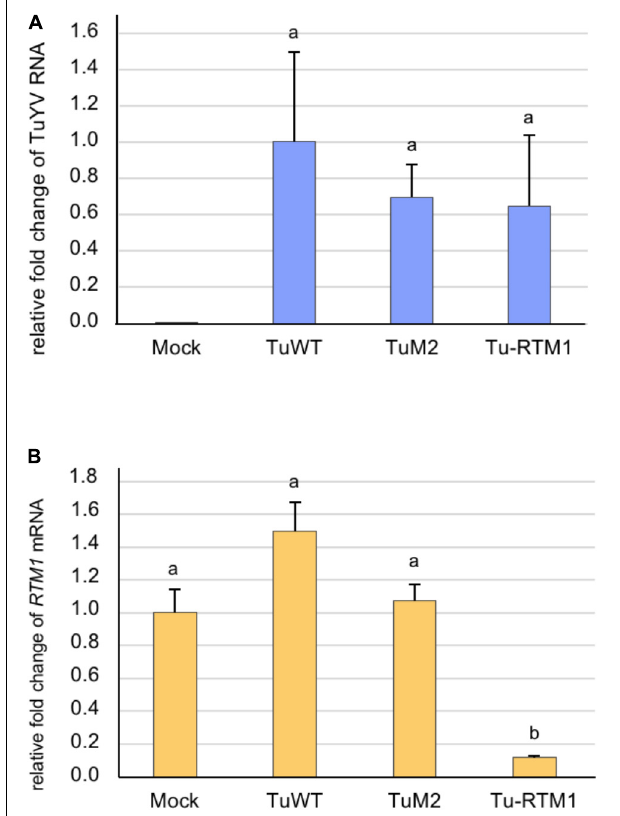
FIGURE 6 | Analysis by real-time RT-PCR of the accumulation of TuYV RNA (A) and RTM1 transcripts (B) in infected A. thaliana Col-0 plants. Plants were either mock-inoculated (mock) or agroinoculated with TuWT, TuM2, or Tu- RTM1 and collected 36 dpi. TuM2 is the parental clone in which the RTM1 sequence was inserted. The bars represent the relative fold-change ± SE of viral RNA or RTM1 transcripts in upper non-inoculated leaves of individual mock or infected plants. The TuYV value in infected TuWT control plants and the RTM1 value in the mock-inoculated plants were arbitrarily set to 1 as a reference. Statistical analyses were performed using one-way ANOVA following by Tukey’s post-hoc test. Different letters above the bars indicate statistically significant differences for RTM1 transcripts (B) ( p -value < 0.05) while the same letters indicate no statistically significant differences ( A and B